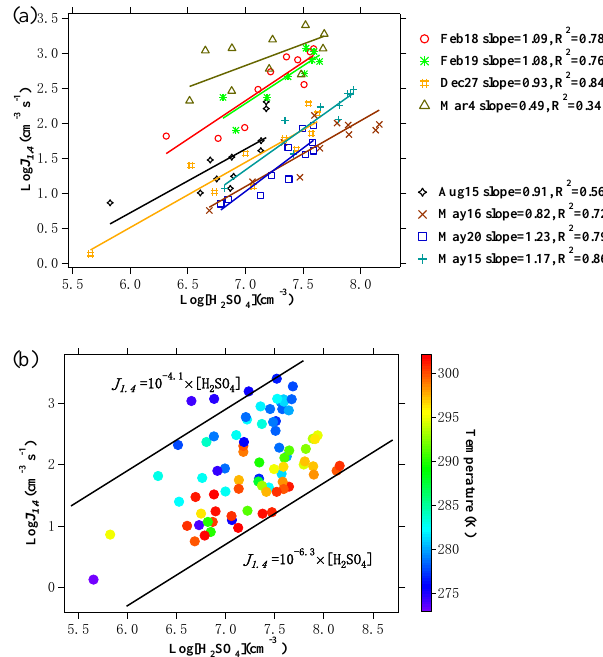
Figure 7. (a) Correlations between log J 1 . 4 and log [H 2 SO 4 ] for the eight events. H 2 SO 4 proxy was calculated according to Mikko- nen et al. (2011). J 1 . 4 and [H 2 SO 4 ] were synchronized to 1h that was the time resolution of solar radiation data. The colored lines showed linear fits to the data of every single event. (b) The same data set as panel (a) , but with symbol color to indicate ambient temperature. Two black lines showed the linear dependences of J 1 . 4 = 10 − 4 . 1 × [H 2 SO 4 ] and J 1 . 4 = 10 − 6 . 3 × [H 2 SO 4 ], between which most of data points